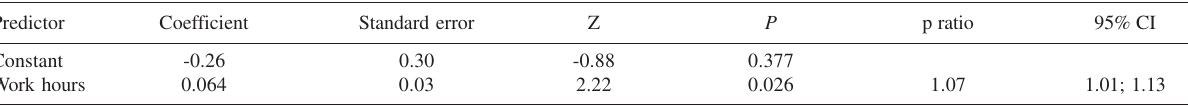
Table 1 - Summary of significant results of logistic model adjustment Predictor